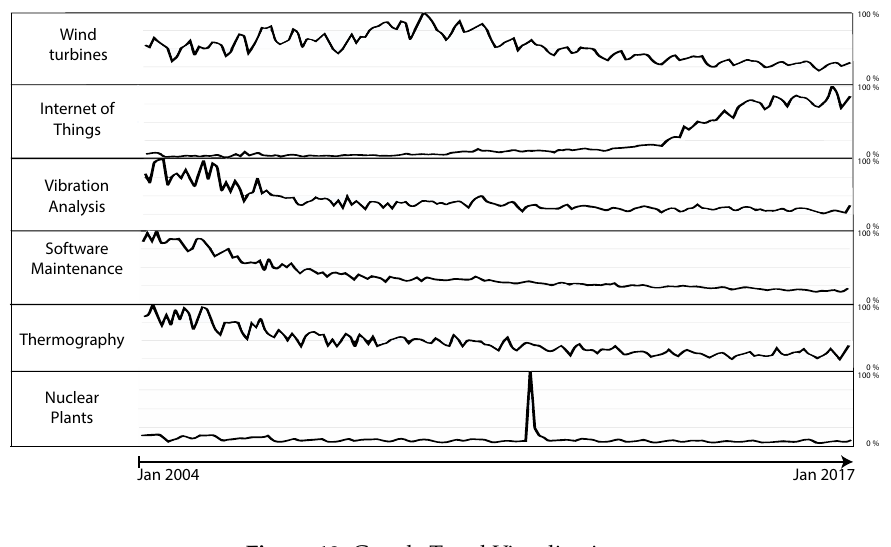
Figure 18. Google Trend